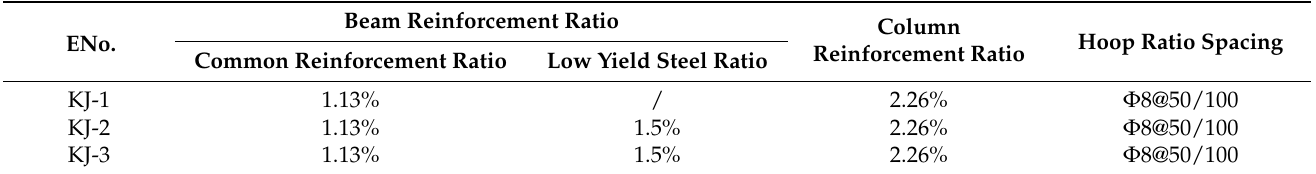
Table 4. Section parameters of the test